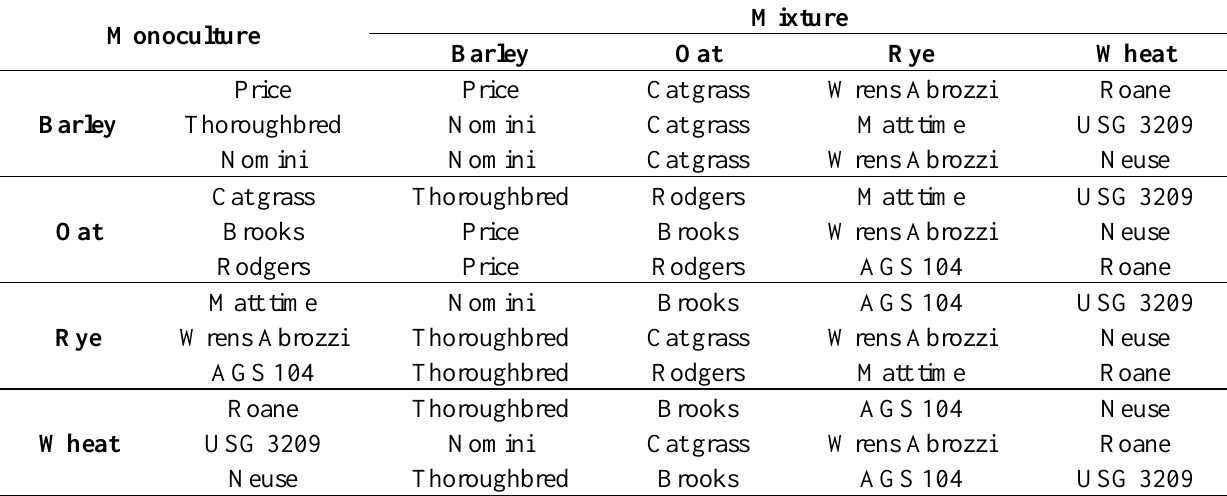
Table 1. Species and cultivars composition for the monoculture and mixture banker plant